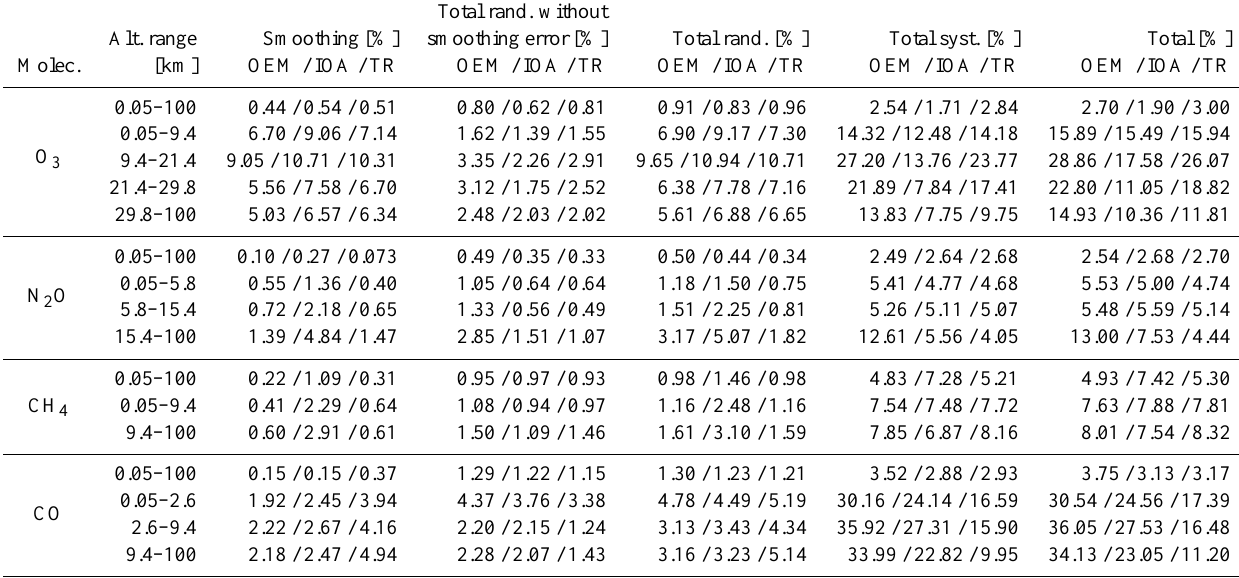
Table 5. Smoothing error, total random error without the smoothing error contribution, total random error, total systematic error and total error on the retrieved total and partial columns of O 3 , N 2 O, CH 4 and CO, at Ile de La R´eunion in 2007, when using the OEM, IOA and TR. Total rand. without Alt. range Smoothing [%] smoothing error [%] Total rand. [%] Total syst. [%] Total [%] Molec. [km] OEM / IOA / TR OEM / IOA / TR OEM / IOA / TR OEM / IOA / TR OEM / IOA / TR